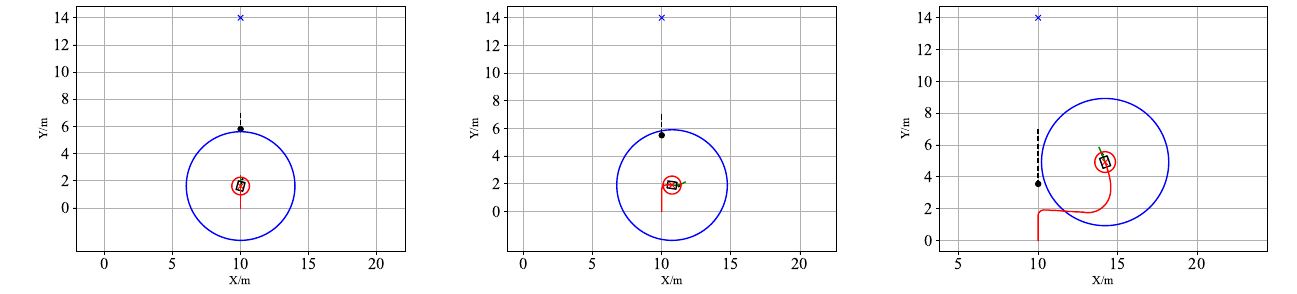
Figure 10. COLREGs-compliant DWA algorithm for head-on situation.